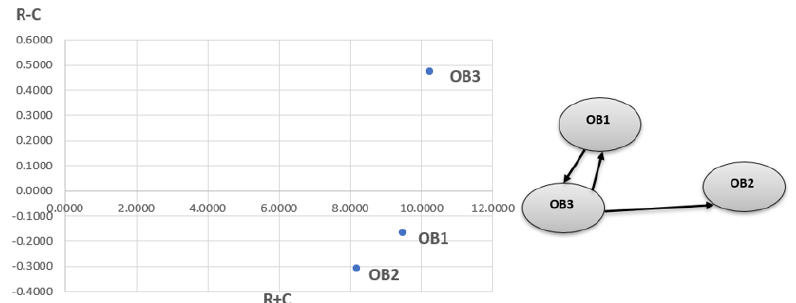
Figure A2. The causal effect graph for the intra-organizational sub-barriers.